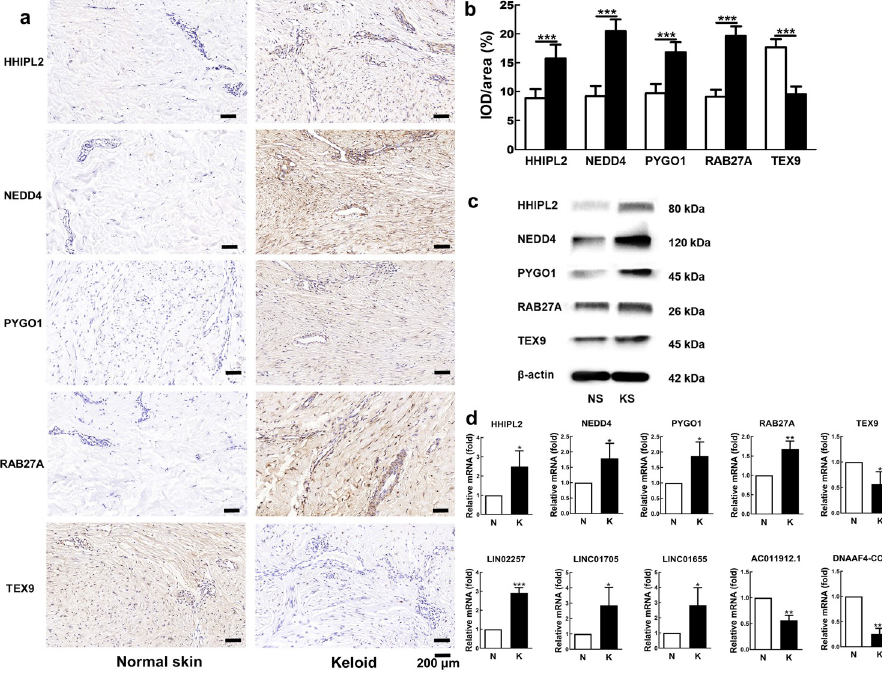
Fig 5. Verification of DEGs/DElncRNAs in vitro . Immunohistochemical staining (A) as well as its semi-quantitative analysis (B) and western blot (C) were used to detect the expression levels of HHIPL2, NEDD4, PYGO1, RAB27A and TEX9 in keloid tissues and their adjacent normal skins. Scale bars = 200 μ m, magnification × 200. RT-qPCR (D) was used to detect the gene expression levels of HHIPL2 , NEDD4 , PYGO1 , RAB27A , TEX9 and LINC02257 , LINC01705 , LINC01655 , lncRNAAC011912 . 1 , DNAAF4-CCPG1 of keloid tissues and their adjacent normal skins. Each assay was repeated in at least three independent samples (respectively from KT1-KT5 samples, � P < 0.05, �� P < 0.01, ��� P <